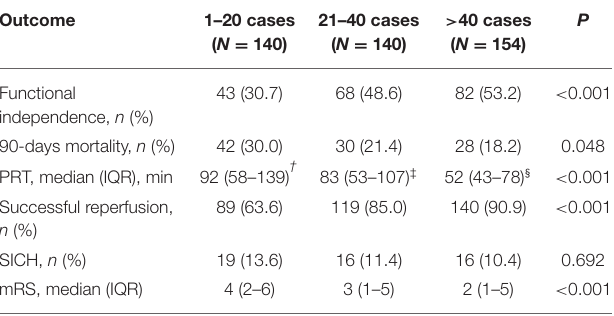
TABLE 2 | Technical, clinical, and safety outcomes according to procedural experience